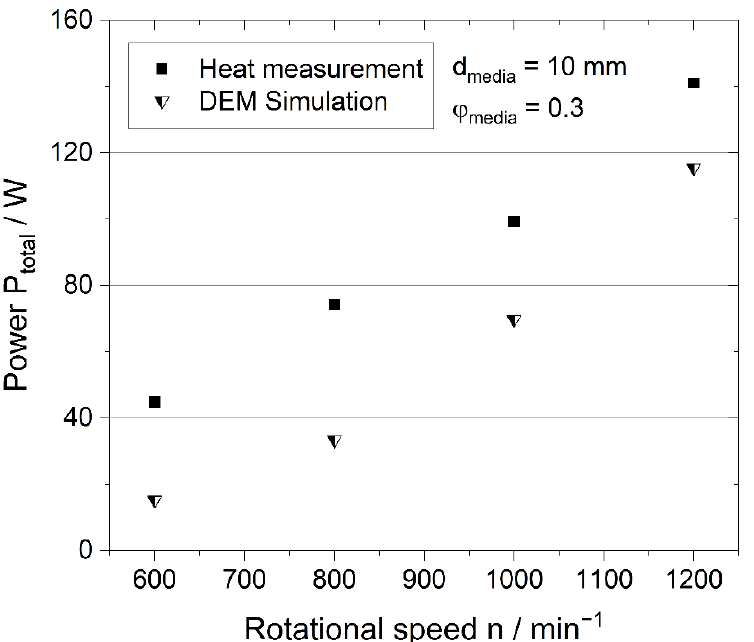
Figure 3. Comparison of power calculated from heat measurement and DEM simulation (one vessel). Temperature taken into account for heat calculation within the first 20 min of measurement (compare Figure 2), ϕ media = 0.3, d media = 10 mm.